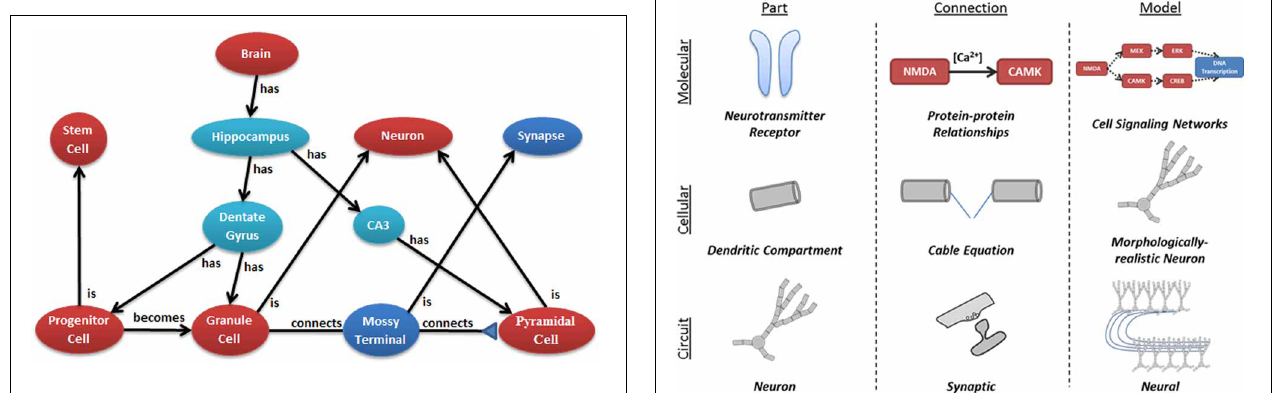
FIGURE 2 | Example of hierarchical relationship of a neural system that can be mapped into N2A. N2A uses a parts/connections framework to describe a model’s components and how they interact. Further, parts and connections can inherit dynamics and relationships from parent parts (e.g., a granule cell is a neuron) that allow the models described within N2A to be related to neurobiological data characterized within neuroinformatics ontologies.